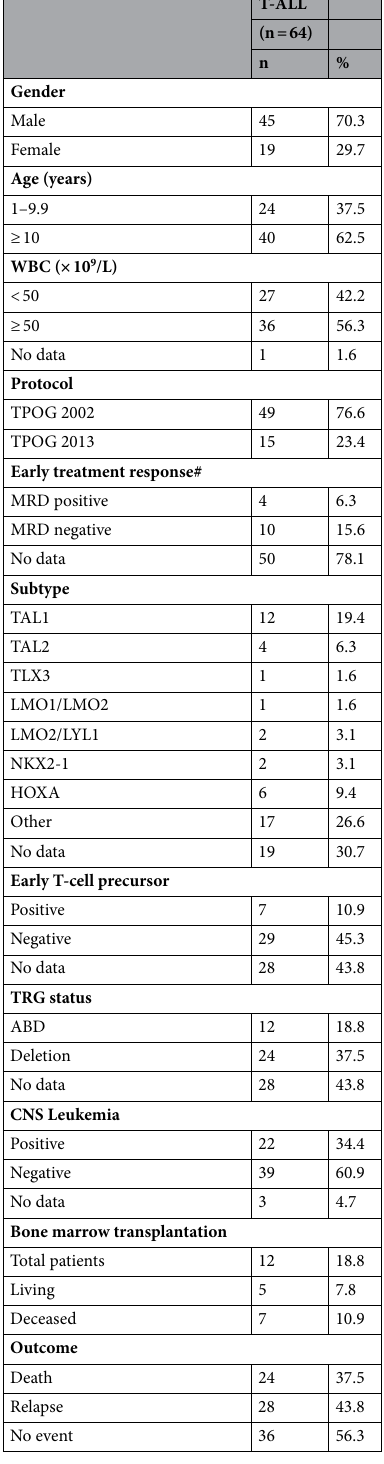
Table 1. Clinical characteristics of this T-ALL